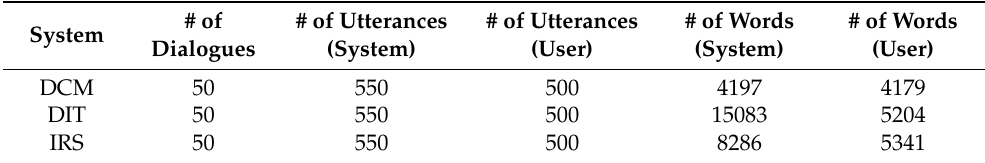
Table 8. Number of dialogues and utterances for each dialogue system.